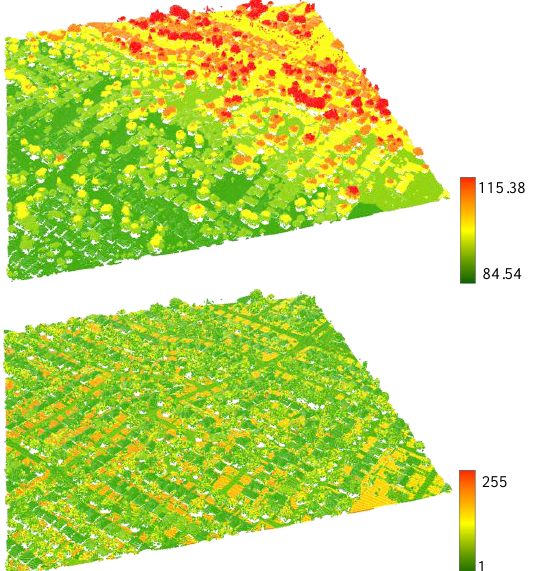
Figure 1. LiDAR point clouds from C2 colorized by elevation (upper) and intensity (lower)